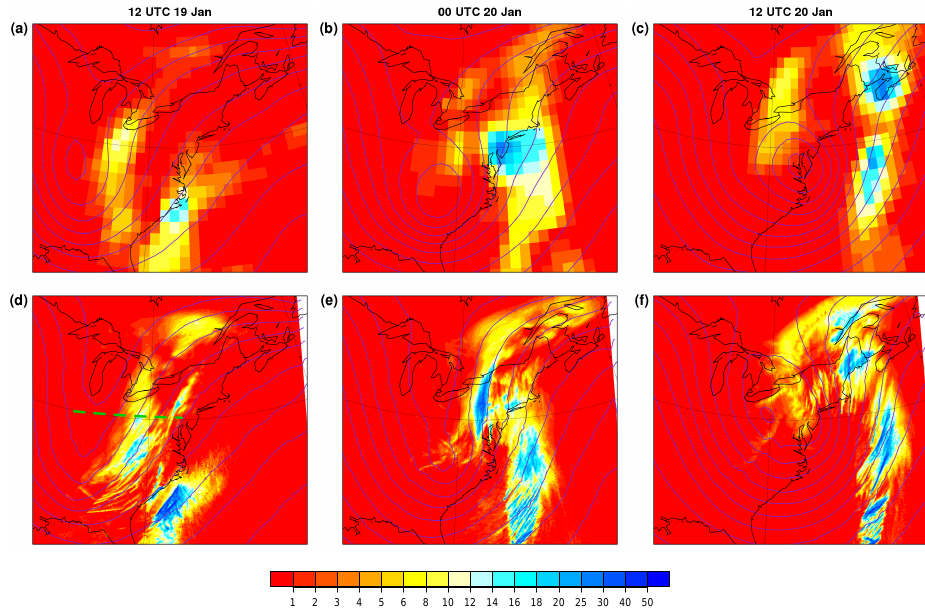
Fig. 3. Six-hourly accumulated surface precipitation (colours, in mm) and geopotential height on 500hPa (purple contours, contour interval 50m) at (a, d) 12:00UTC 19 January, (b, e) 00:00UTC 20 January and (c, f) 12:00UTC 20 January. Precipitation is accumulated from 3h before to three hours after the respective dates. In panels (a–c) , ERA40 reanalysis data are shown, in (d–f) results from the COSMO iso simulation. The green dashed line in panel (d) indicates the position of the vertical cross section shown in Figs. 10 and